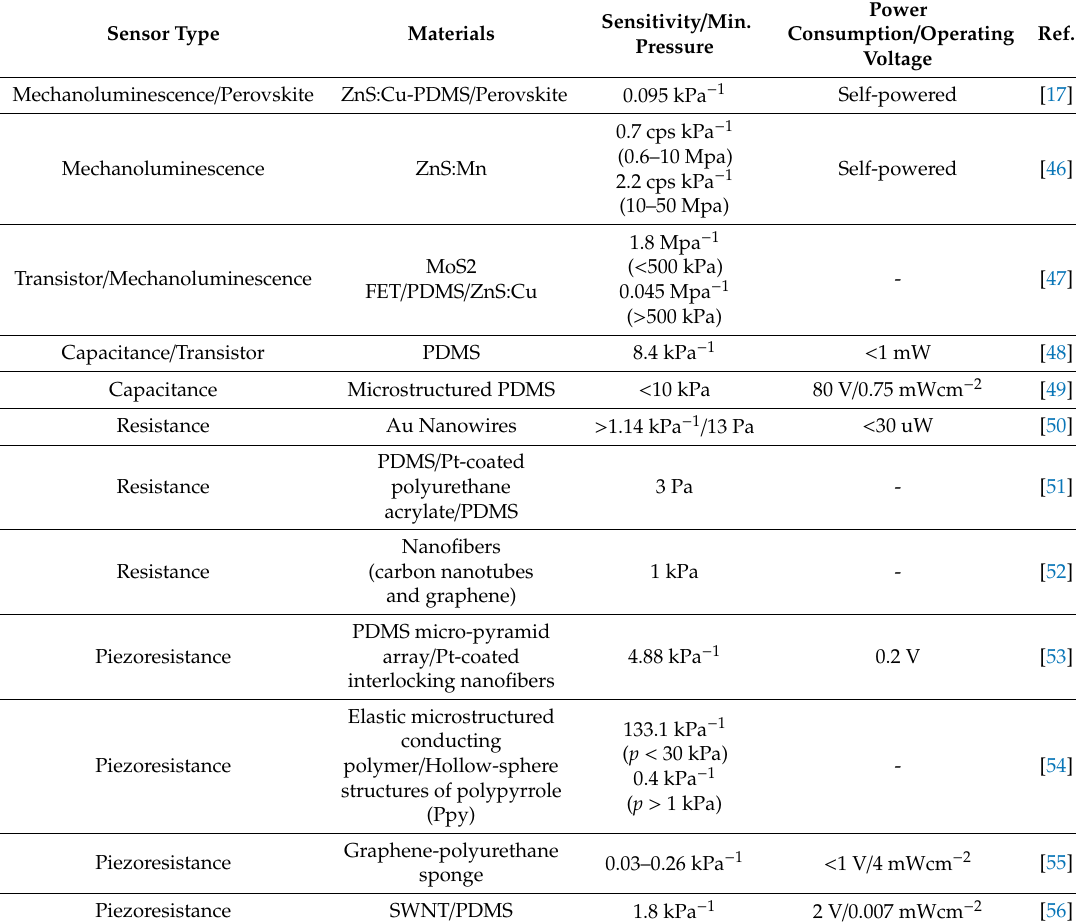
Table 1. Comparison of the performance parameters of di ff erent types of